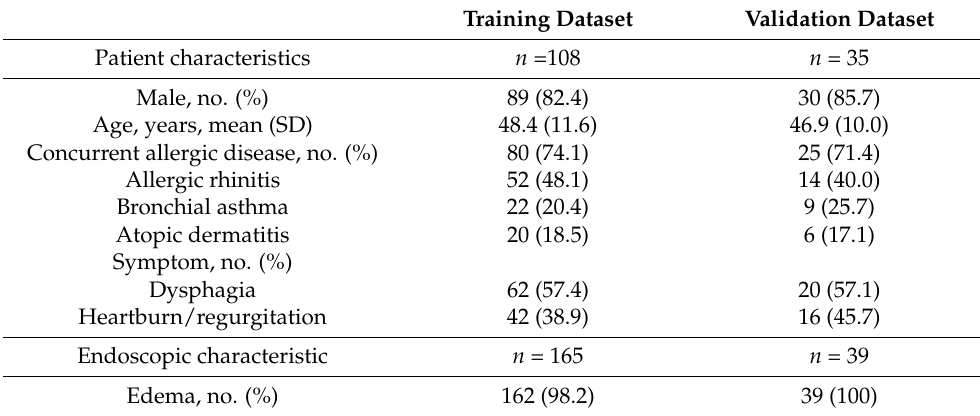
Table 1. Clinical characteristics of enrolled patients in training and validation